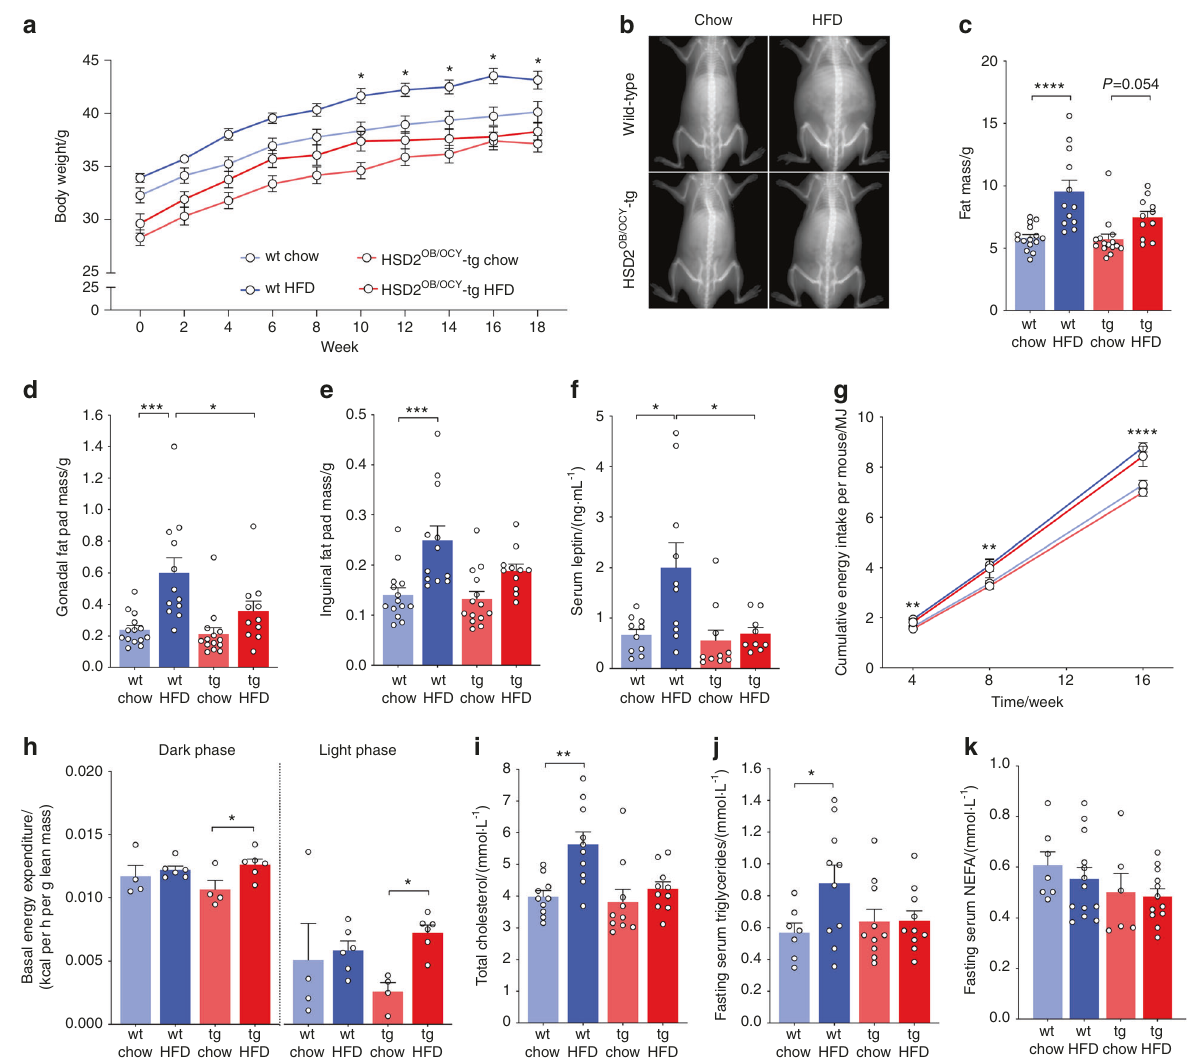
Fig. 7 When fed a HFD, HSD2 OB/OCY -tg mice gained less weight, due to increased energy expenditure, and were protected against HFD- induced dyslipidemia. a Body weight of wild-type and HSD2 OB/OCY -tg mice fed either regular chow or a HFD ad libitum for 18 weeks. The results are shown as the mean ± SEM, n = 18, 15, 14, and 13 mice for wt chow, wt HFD, HSD2 OB/OCY -tg chow, and HSD2 OB/OCY -tg HFD, respectively. b Representative DEXA scans of wild-type and HSD2 OB/OCY -tg mice after 18 weeks of either chow or HFD feeding. c Body composition of wild-type and HSD2 OB/OCY -tg mice fed either chow or HFD for 18 weeks. The results are shown as scatterplots, with the mean ± SEM shown in columns. The effects of diet and genotype were signi fi cant (diet: F 1,49 = 25.90, P < 0.000 1; genotype: F 1,49 = 4.266, P = 0.044). d Gonadal fat pad mass at sacri fi ce. The effects of diet and genotype were signi fi cant (diet: F 1,47 = 18.18, P < 0.000 1; genotype: F 1,47 = 5.194, P = 0.027 2). e Inguinal fat pad mass at sacri fi ce. The effect of diet was highly signi fi cant ( F 1,47 = 19.53, P < 0.000 1). f Plasma leptin concentrations at sacri fi ce. g Cumulative food intake for chow- and HFD-fed wild-type and HSD2 OB/OCY -tg mice. At each timepoint, n = 3 – 10 cages. h Energy expenditure in the dark (left) and light (right) phases, measured after 8 weeks of chow/HFD feeding. Energy expenditure was normalized to lean body mass. In the dark phase, the overall effect of diet was signi fi cant ( F 1,16 = 5.146, P = 0.038). i Fasting serum concentrations of cholesterol. The effects of diet and genotype were signi fi cant (diet: F 1,36 = 10.78, P = 0.002 3; genotype: F 1,36 = 6.268, P = 0.017). j Fasting serum concentrations of triglycerides and k nonesteri fi ed fatty acids (NEFAs). Signi fi cance was determined using two-way ANOVA, with Tukey ’ s multiple comparison tests used for post hoc testing. In all cases, * P < 0.05, ** P < 0.01, *** P < 0.001, and **** P < 0.000 1 for the indicated glucose intolerance, and dyslipidemia in HFD-fed HSD2 OB/OCY -tg Although skeletal glucose uptake (per unit mass) is lower than that in other tissues, such as skeletal muscle and adipose tissue, its mice were all markedly attenuated, despite identical caloric intake. sheer size and cellular density (estimate of ~42 billion osteocytes Similarly, other studies of mice with increased glucose uptake and within the average adult human skeleton) suggest that it makes a utilization in bone also display improved whole-body glucose signi fi cant contribution to overall glucose homeostasis. In tolerance and protection against central obesity during aging, 42 anesthetized mice, the skeleton accounts for ~15% of total while inhibiting glucose uptake in osteoblasts and osteocytes is glucose uptake. 42 The wider metabolic signi fi cance of the accompanied by obesity, glucose intolerance, and insulin resis- tance in mice. 29,43,44 increased glucose uptake into osteoblastic cells is well illustrated here by the phenotype of HFD-fed HSD2 OB/OCY -tg mice: compared Taken together, these fi ndings support the emerging view that to wild-type mice, the development of obesity, insulin resistance, glucose metabolism in osteoblasts and osteocytes makes a